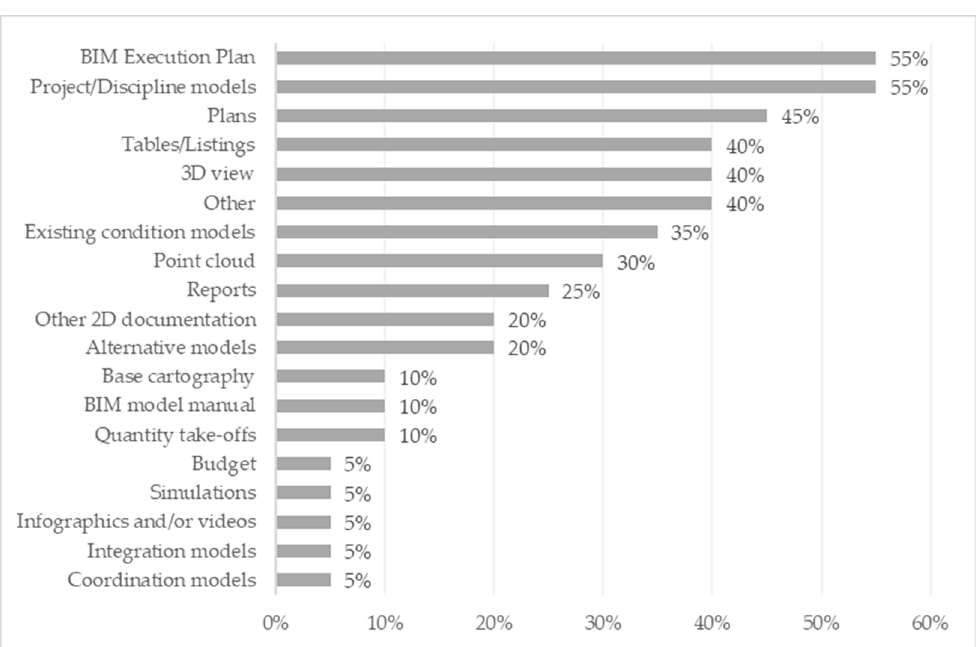
Figure 9. BIM deliverables identified in the analyzed contracts.